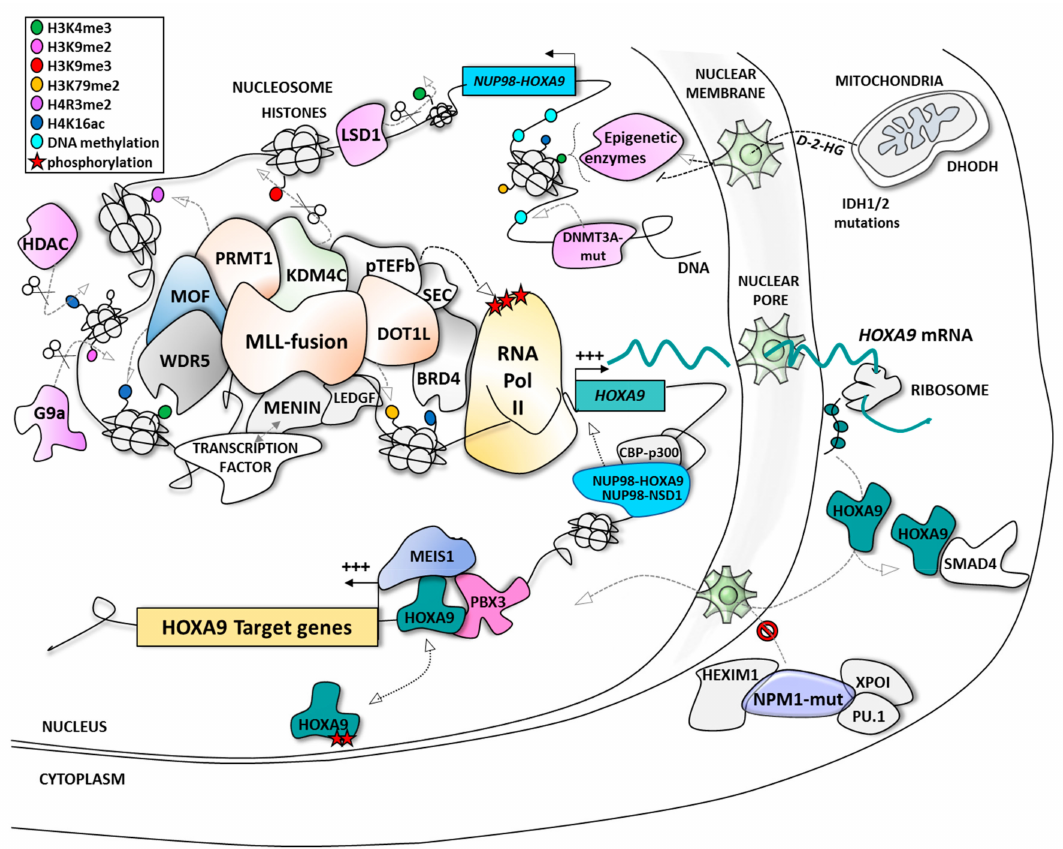
Figure 1. The di ff erent modes of regulation of HOXA9 expression and function in acute myeloid leukemia (AML). BRD4, bromodomain-related protein 4; CBP, CREB-binding protein; CDK9, cyclin-dependent kinase 9; D-2-HG, D-2-hydroxyglutarate; DHODH, dihydroorotate dehydrogenase; DNMT3A, DNA methyl transferase 3A; DOT1L, disruptor of telomeric silencing 1-like protein;